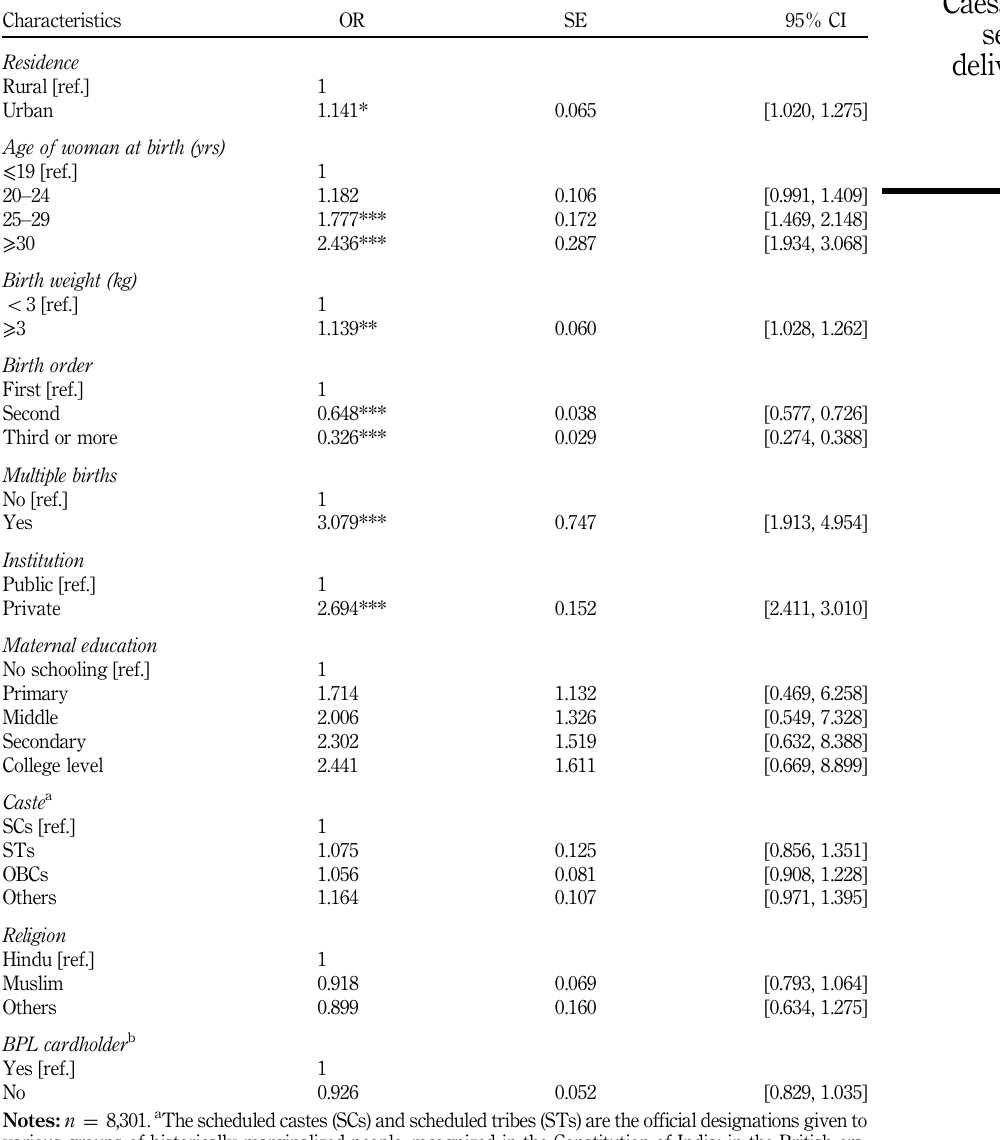
Table IV. Logistic regression results; likelihood estimates of